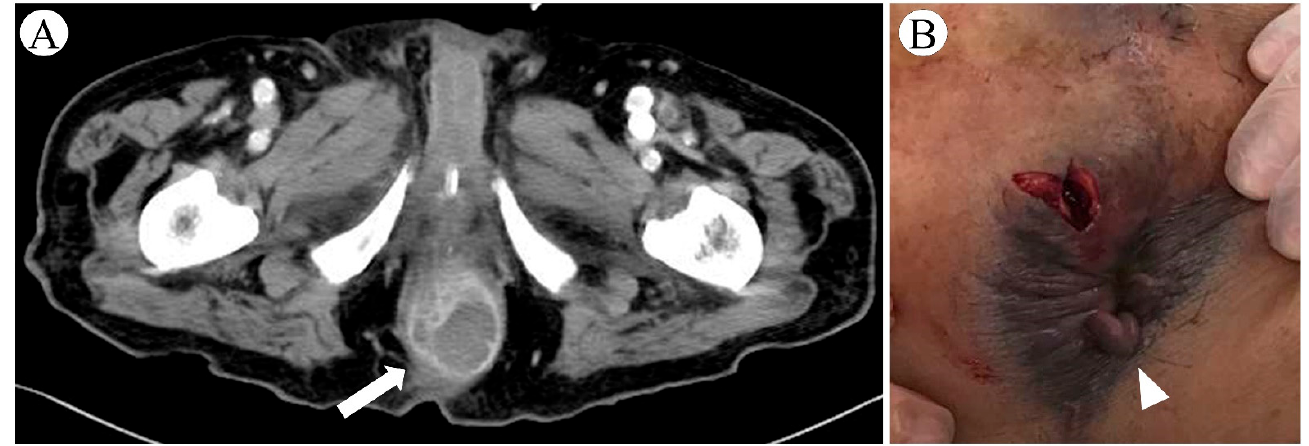
Figure 3. Perianal abscess in a patient with severe coronavirus disease 2019: ( A ) enhanced computed tomography revealed a horseshoe-shaped collection of fluid, 35 mm in diameter, surrounding the anus; ( B ) appearance of perianal region after incision and drainage—external examination before drainage showed only a skin tag without swelling around the anus.